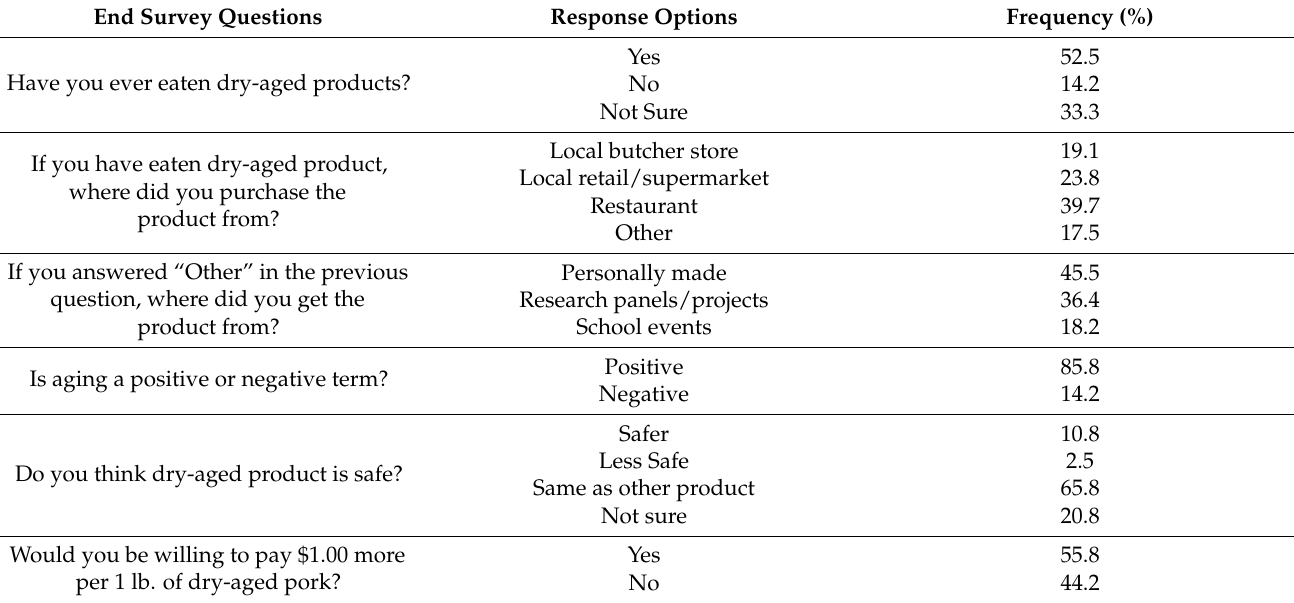
Table 4. Consumer panelist perceptions on dry-aging and willingness to pay ( n =